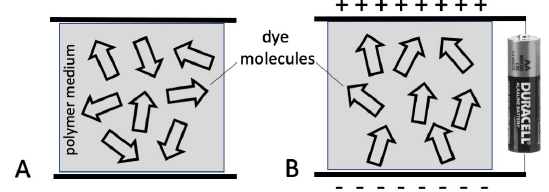
Figure 3: Schematic diagram showing a random arrangement of dye molecules (A) and alignment of dye molecules in an electric field (B). The arrows represent the dipole moments of molecules with a different top and bottom. “Poling efficiency” is a measure of the extent of alignment of the dye molecules (arrows) with an applied electric field. The field is supplied by a power supply. In this scheme, the 1.5-volt Duracell battery is merely illustrative. Typically, one supplies 100 volts across a very narrow polymer film whose thickness is one micron (one-millionth of a